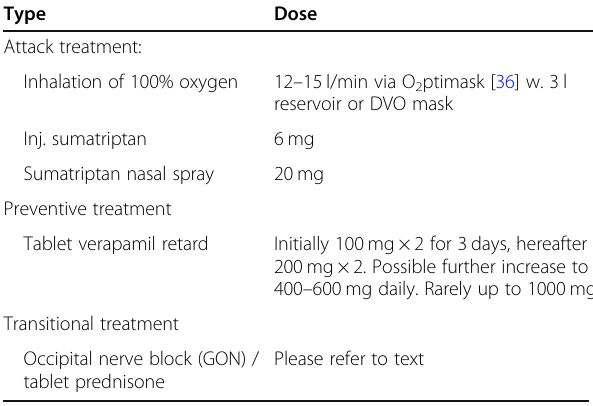
Table 15 Pharmacological treatment of cluster